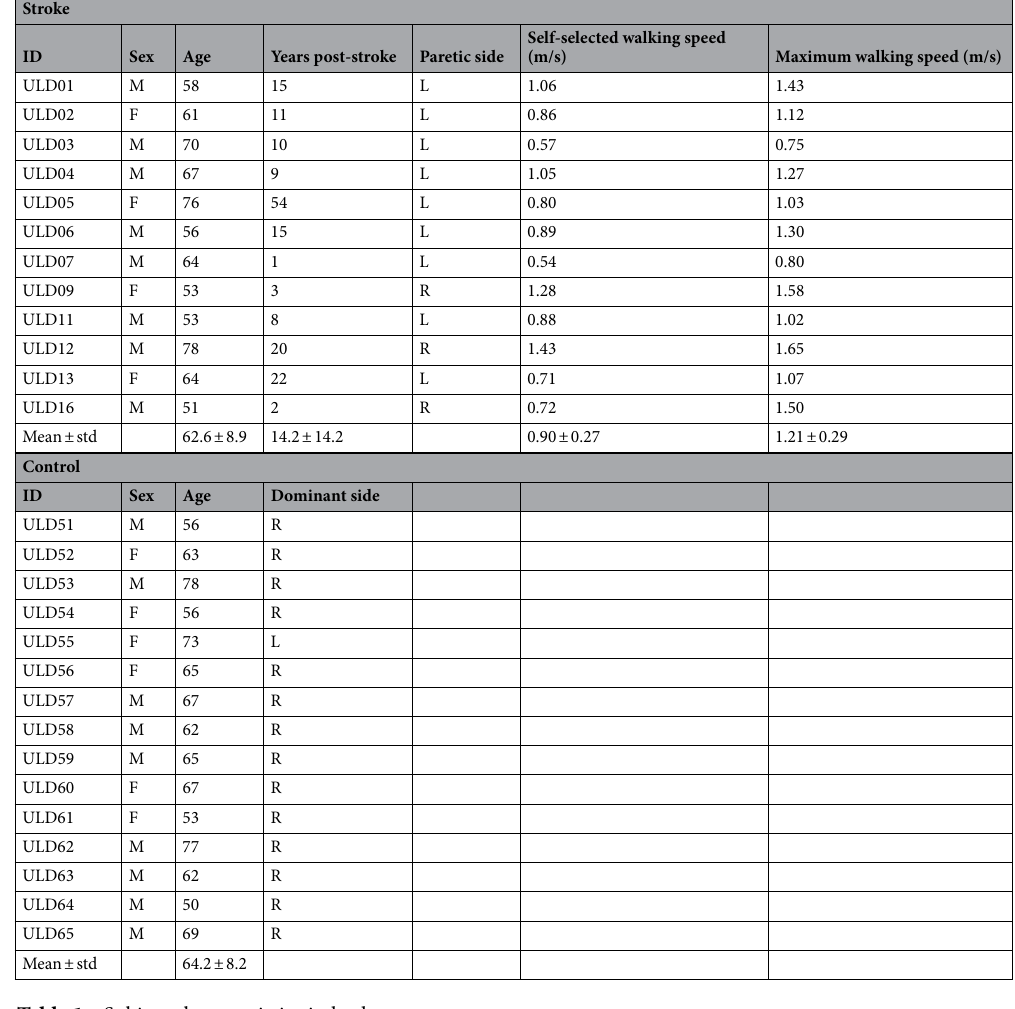
Table 1. Subject characteristics in both